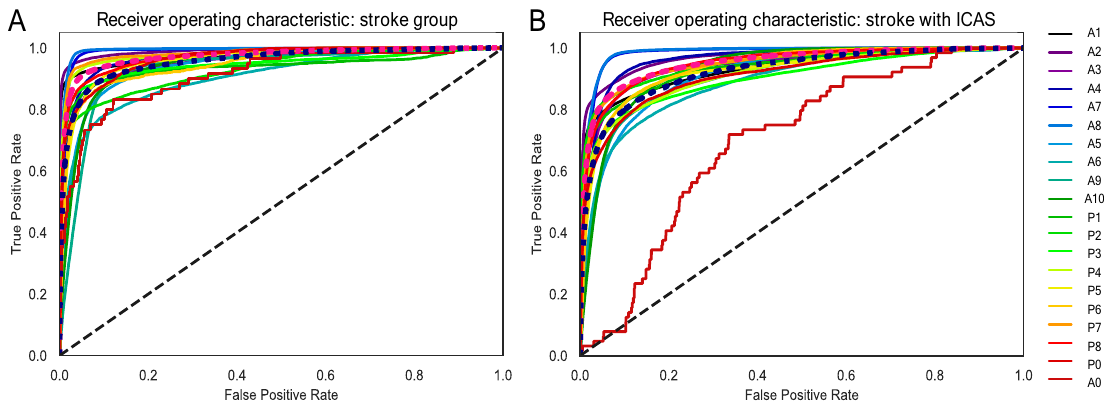
Figure 4. External validation via the receiver operating characteristic in the stroke-only and stroke-with-ICAS groups. Analysedsed the area under the receiver operating characteristic curve for the external validation of each spot’s deep neural network ensemble to a specific chunk for stroke patients. The employed model ensemble received training only with a control group tested and validated by ( A ) the stroke group and ( B ) the stroke-with- ICAS